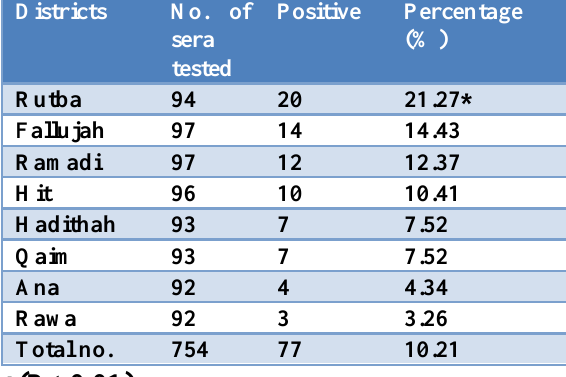
Table, 1: Rate of infection of sheep brucellosis by using RBPT according to areas of study